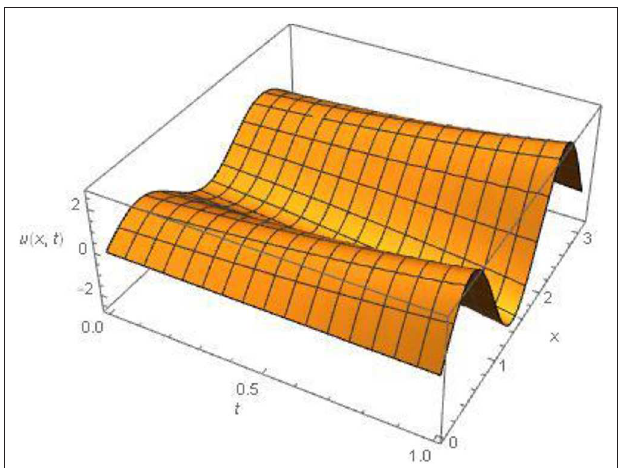
FIGURE 7 | Approximate solutions of TFPPDE (29) for distinct values of α 2. = 1.5, 1.75, 2.